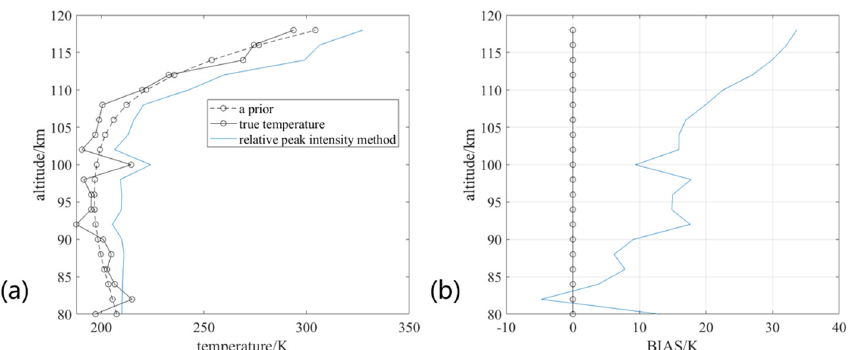
Figure 14. ( a ) Retrieval of atmospheric temperature in MLT region; ( b ) the bias between retrieved temperature and actual temperature at different tangent heights.